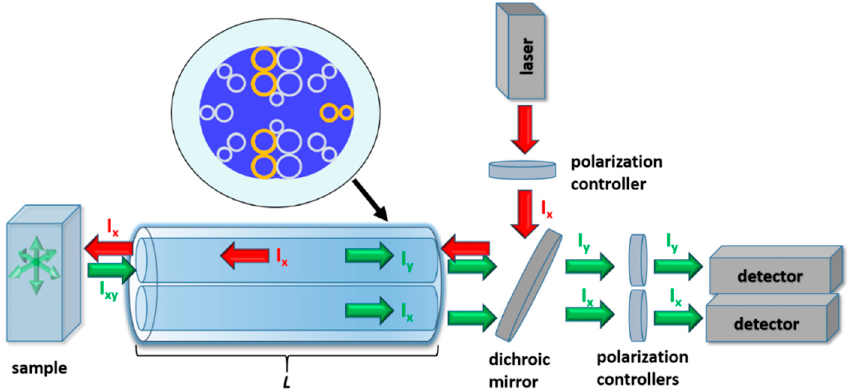
Figure 4. Fluorescence anisotropy measurement setup based on a DHC-ARF with length L . The excitation beam (laser) is coupled into one of the cores (excitation core) of the DHC-ARF. After the sample is excited, its fluorescence signal is collected via the same core. During the back-propagation of fluorescence, its two orthogonal polarization states are separated (one in each core of the DHC-ARF). Finally, their intensities are measured using two detectors. The presence of polarization controllers in front of the detectors allows the user to eliminate any signal with an unwanted state of polarization.